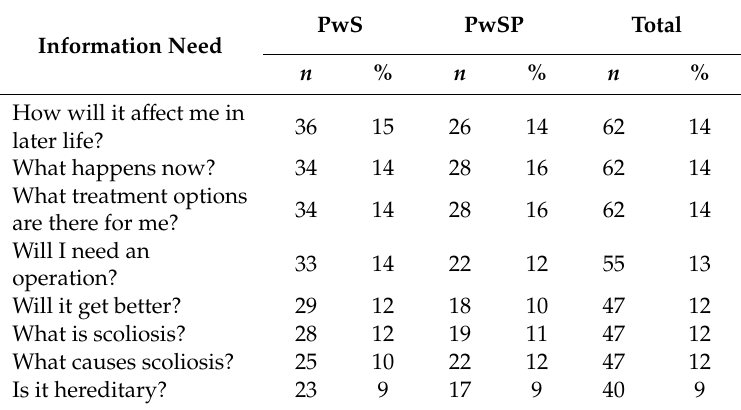
Table 4. Distribution of information needs